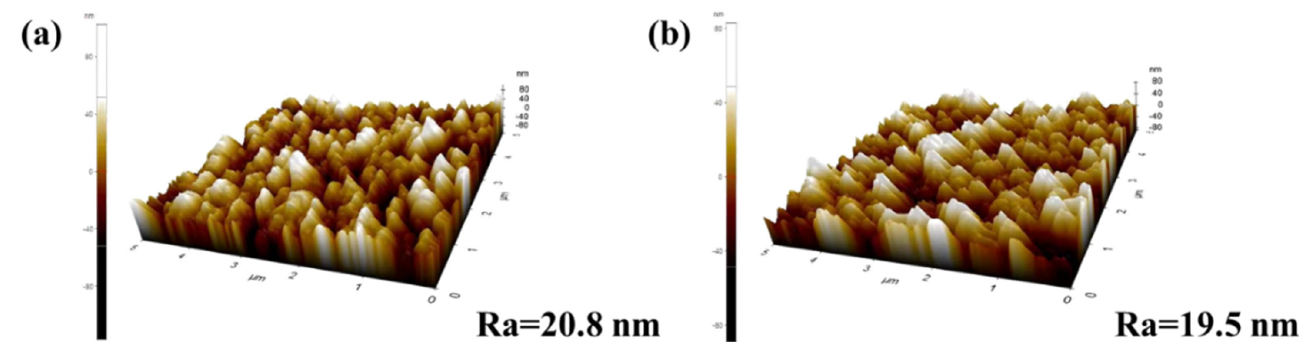
Figure 6. Atomic force microscope (AFM) images of the α -Al 2 O 3 membrane ( a ) before and ( b ) after modification.